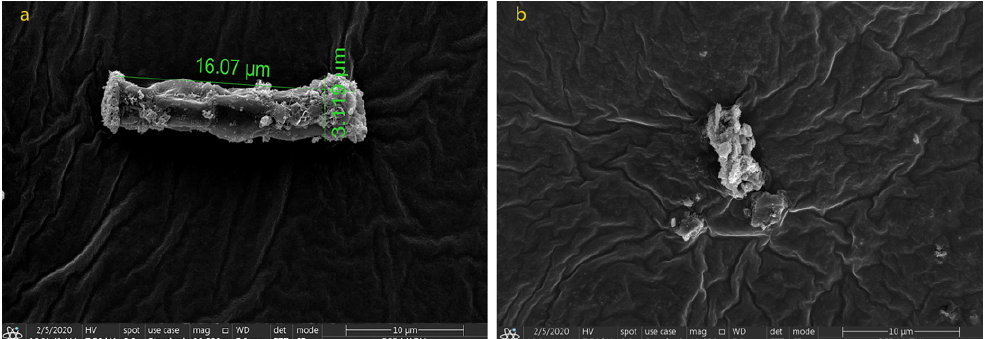
Figure 5. Morphological changes of N. shiloi in response to different nitrogen sources ( a ) NaNO 3 and ( b ) CH 4 N 2 O.